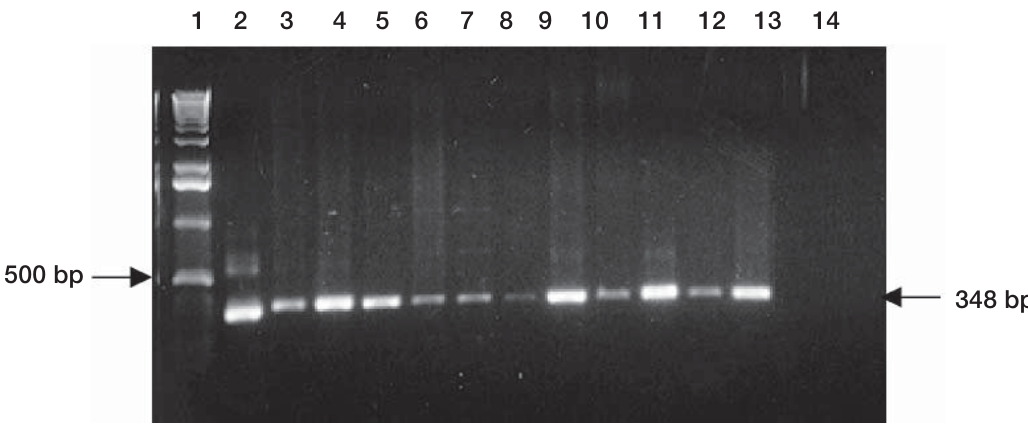
Fig. 2. Agarose gel (1.5%) electrophoresis of IR DNA amplicons obtained from tomato samples. Lane 1, 1 kb ladder (BRL); lane 2, intergenic region of the Egyptian isolate(cid:31)amplified using IRv 21 and IRc 287 primers; lanes 3 to 13 correspond, respectively, to TYLCV-Bn/Bz/Cb/Ch/Dk/Ge/Ha/Mk/Pim1/Pim2 and TYLC-Tb amplified IR region us- ing M14-M15 primers; lane 14, healthy